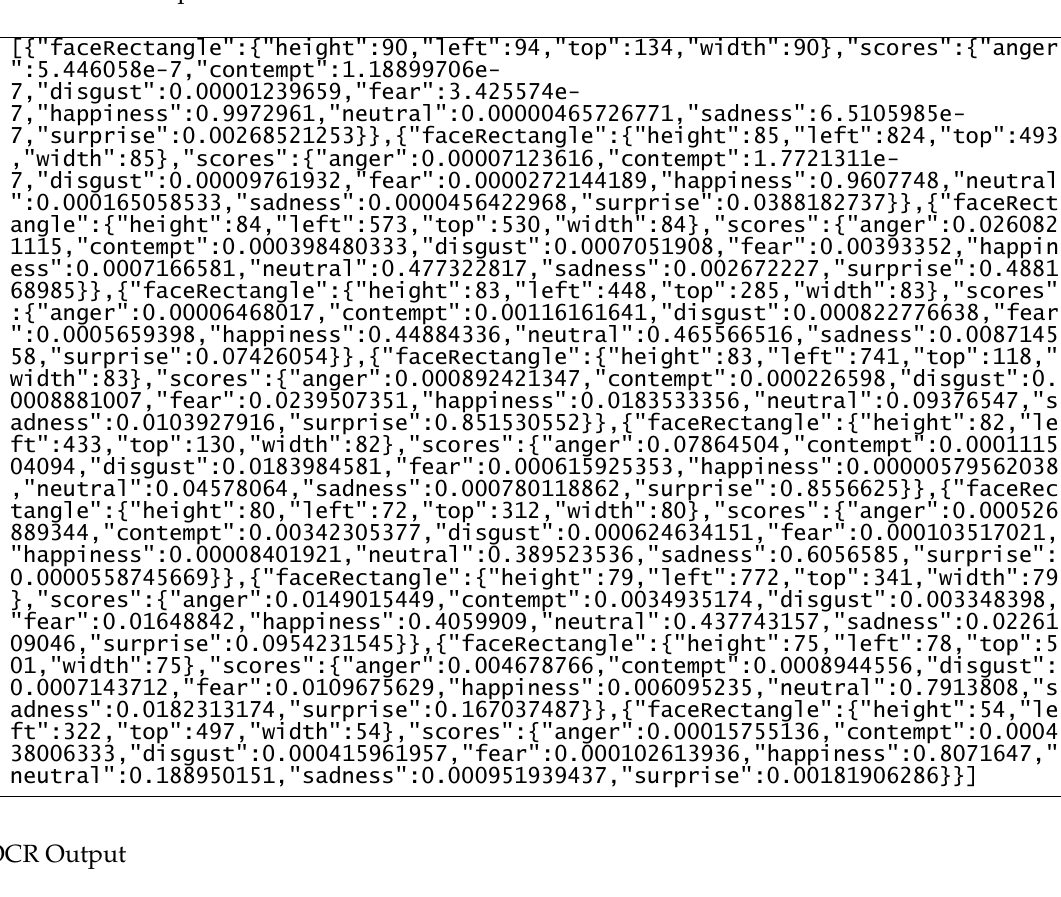
Figure 3. Sample image 3 and related API output. Computer Vision API Output {"categories":[{"name":"others_","score":0.01171875}],"adult":{"isAdultContent" :false,"isRacyContent":false,"adultScore":0.019649172201752663,"racyScore":0.02 1160688251256943},"tags":[{"name":"person","confidence":0.9494146108627319},{"n ame":"indoor","confidence":0.8868169188499451}],"description":{"tags":["person"